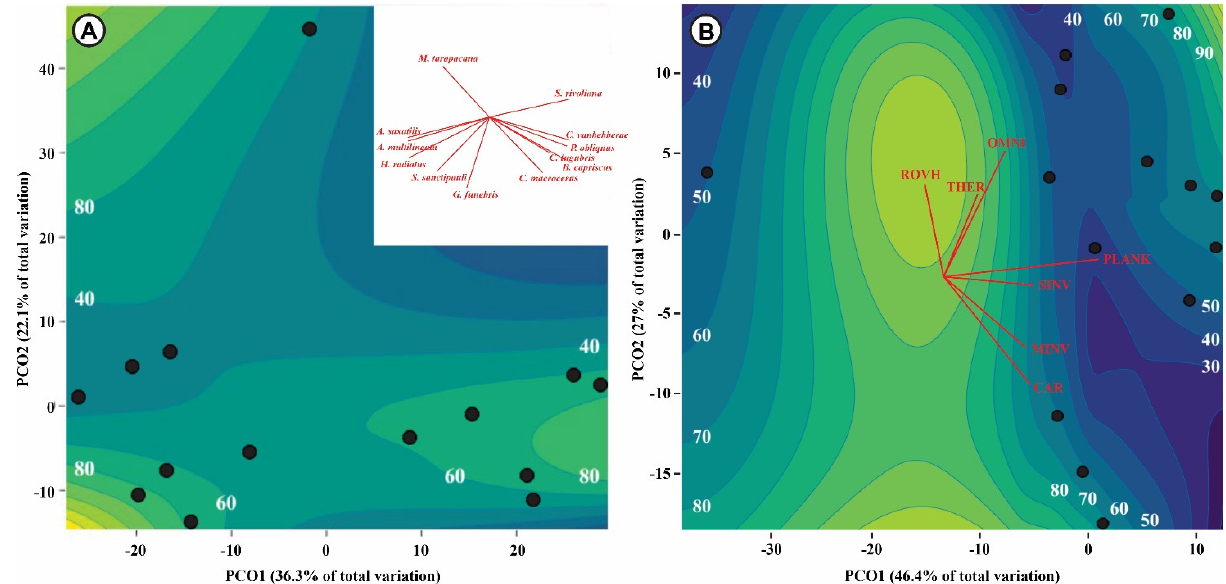
Figure 3. Principal coordinate analysis plots based on the relative abundance of ( A ) species and ( B ) trophic groups. Species with Spearman correlations > 0.65 and the trophic groups are overlaid with their respective vectors. Each dot represents a BRUVS deployment. White numbers indicate the depth gradient.